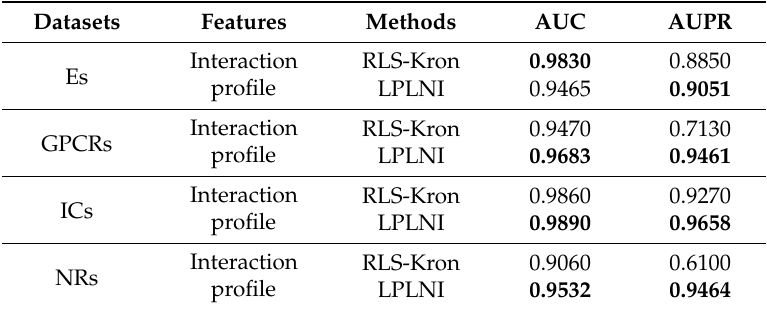
Table 2. Performances of LPLNI and RLS-Kron based on the interaction profiles.